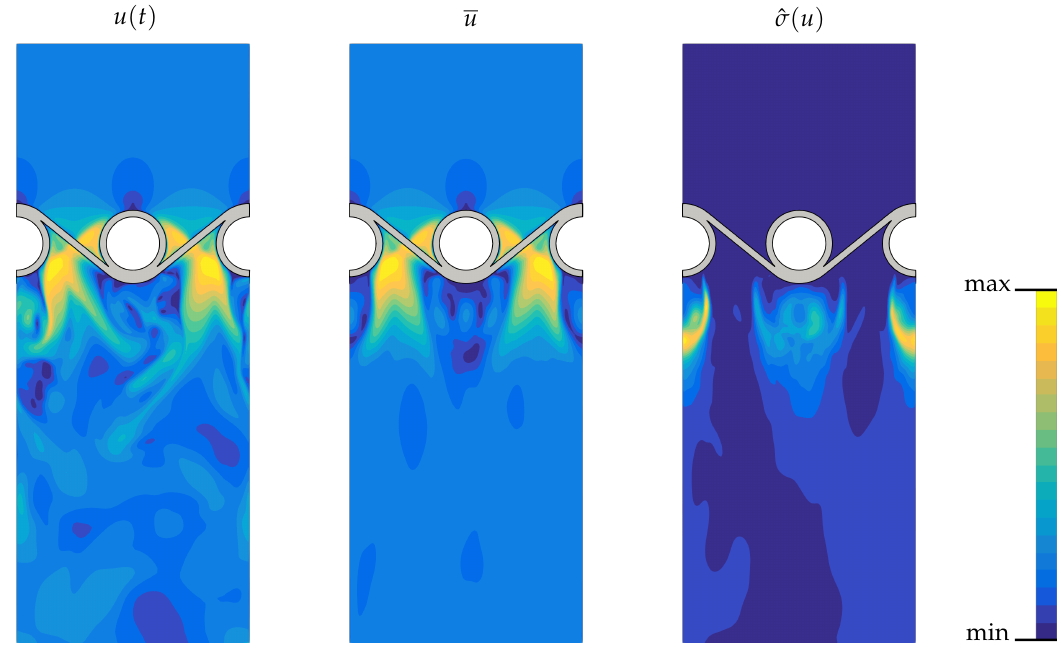
Figure 4. Gas phase velocity field from numerical simulation. Left: Velocity magnitude u at time t , middle: temporal mean velocity u and right: temporal standard deviation of velocity magnitude ˆ σ ( u )